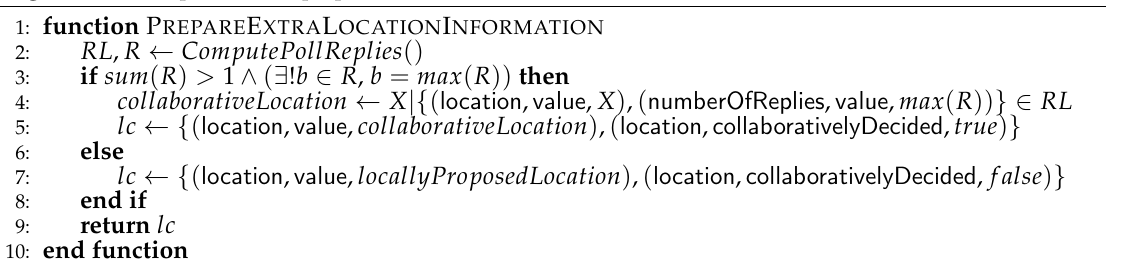
Algorithm 8 : at producer P , prepare extra location information (Collaborative architecture)